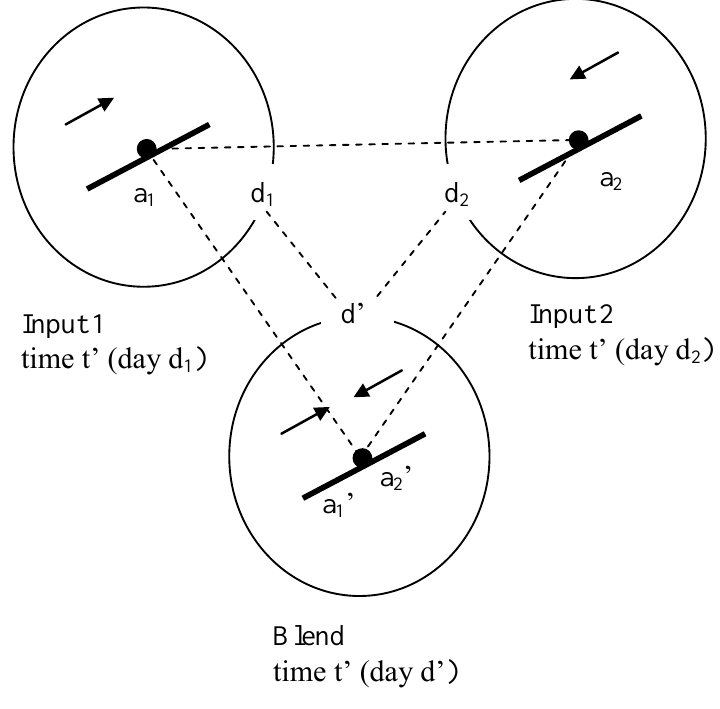
Figure A1.1. Conceptual blending as a solution to the Buddhist monk riddle (adapted from Fauconnier and Turner 1998:141, Fig.